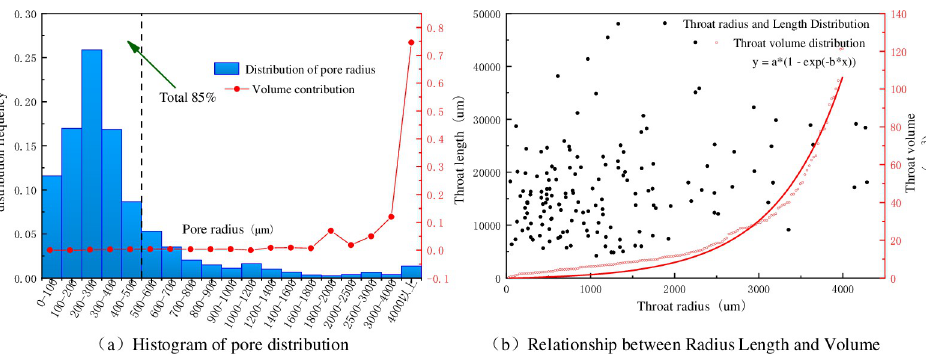
Fig 7. Distribution frequency of pore radius, pore throat radius and pore throat